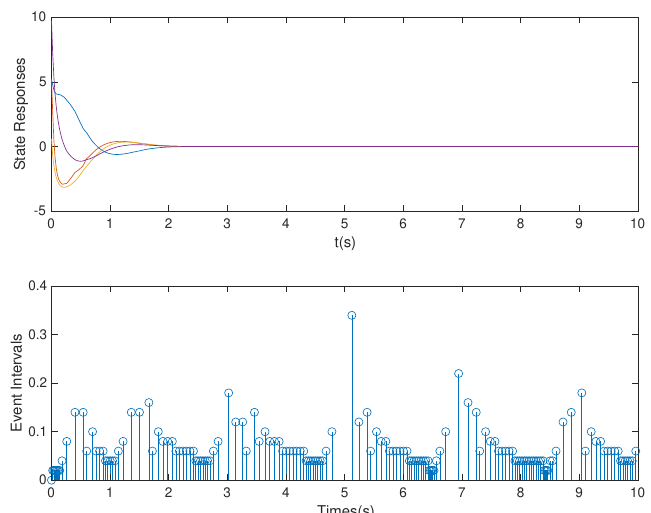
Figure 5. State responses and event intervals with DoS attack for OB-ETPC.